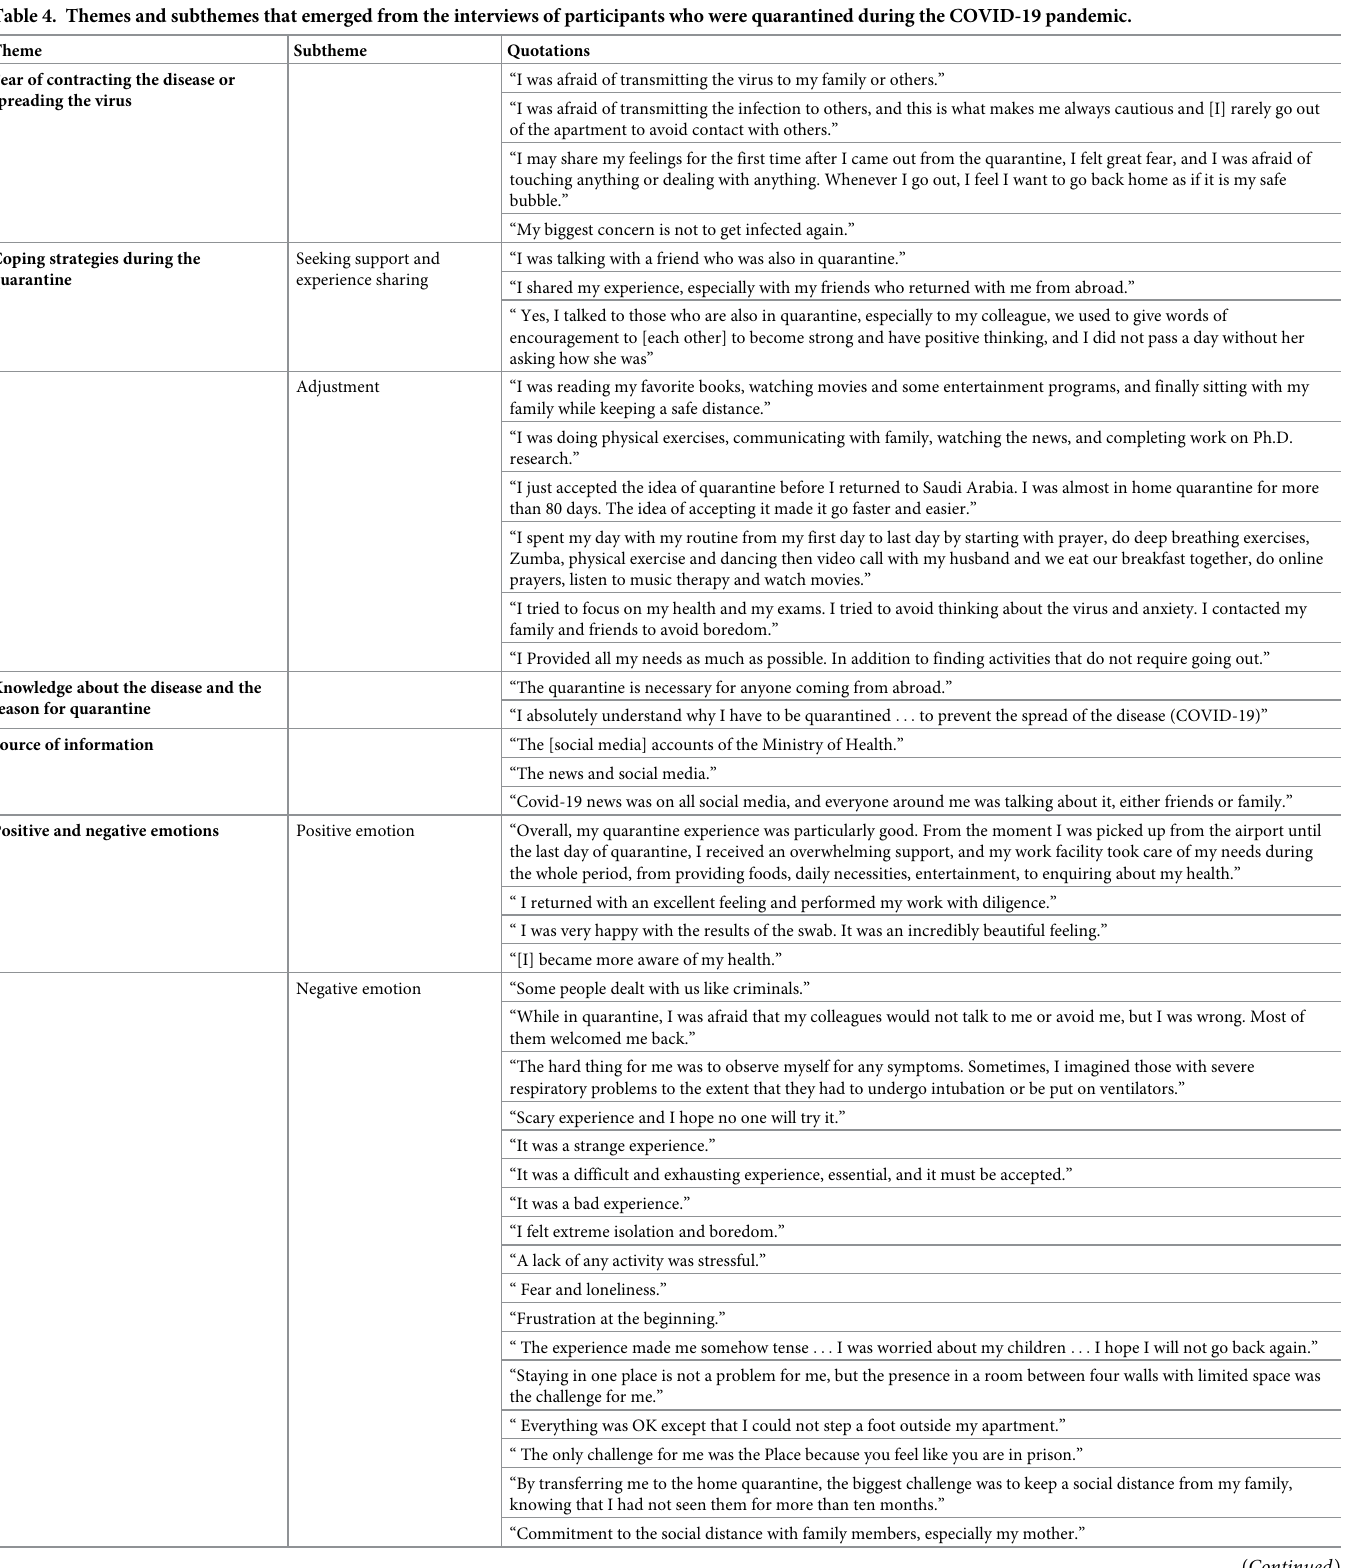
Table 4. Themes and subthemes that emerged from the interviews of participants who were quarantined during the COVID-19 pandemic. Theme Subtheme Quotations Fear of contracting the disease or spreading the